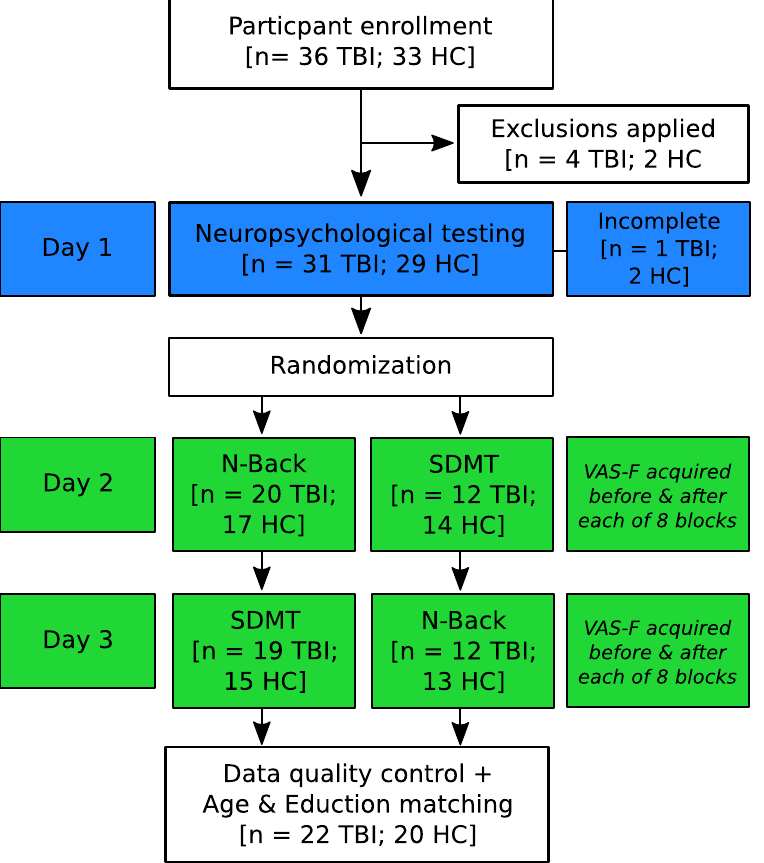
Figure 1. A flow diagram of the experimental design. Thirty-six individuals with TBI and 33 HCs were enrolled. After exclusions were applied (e.g., MRI incompatibility, psychiatric history, claustrophobia), the sample was reduced to 32 individuals with TBI and 31 HCs. Subjects then participated in a day of neuropsychological (NP) testing. Three subjects did not complete the NP test battery (1 TBI, 2 HC), and because the focus of the current study was on functional neuroimaging, these subjects were retained in the sample. Subjects were then randomized into two groups. One group performed the N-Back test while in the fMRI scanner on Day 2 and the SDMT task in the scanner on Day 3. For the other group, the order of N-Back and SDMT tasks was reversed. There was some attrition during this three-day experiment, resulting in a final sample of 31 individuals with TBI and 28 HCs. After applying data quality control (e.g., excluding subjects with excessive motion) and matching the two groups on Age and Education, the final sample was 22 individuals with TBI and 20